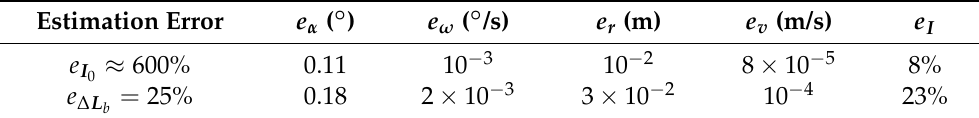
Figure 9. The errors of the estimations after the collision with large errors of initial inertial parameters: ( a ) errors of the Euler angle estimations; ( b ) errors of the angular velocity estimations; ( c ) errors of the relative position estimations; ( d ) errors of the relative velocity estimations; ( e ) errors of the moment of inertia estimations; ( f ) errors of the product of inertia estimations. Table 2. Estimation errors of the state variables when t = 2000